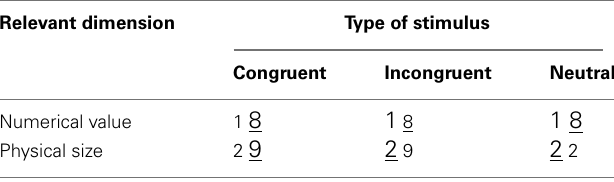
Table 1 | Examples of the stimuli in a numerical Stroop task. Relevant